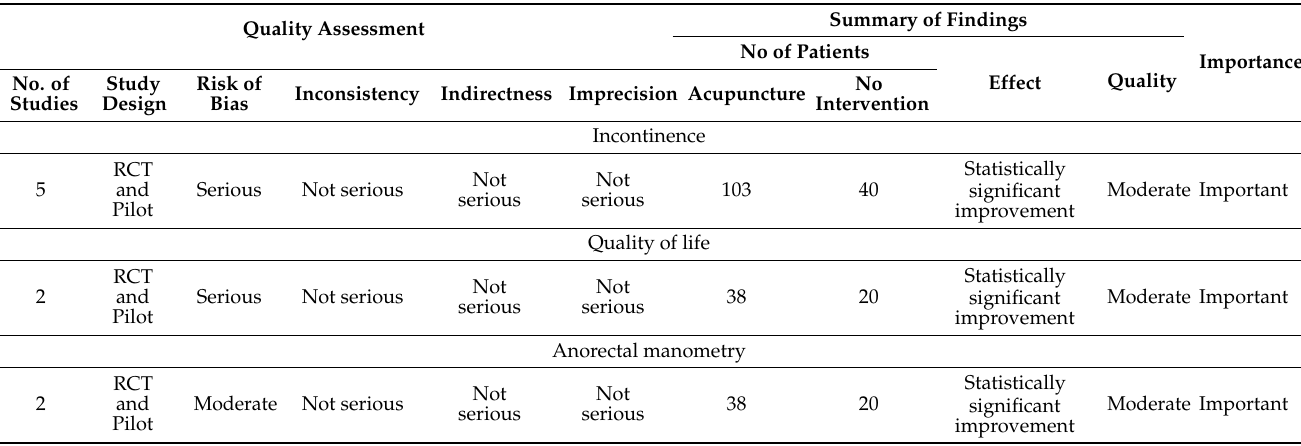
Table 3. Quality of studies included in the